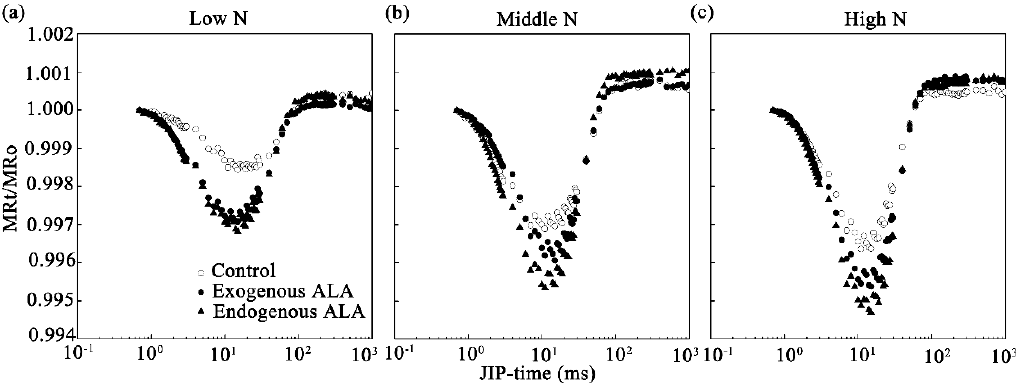
Figure 5. Changes in 820-nm modulated reflection (MR) curves, expressed as normalized MR (represented as MR t /MRo), in exogenously-treated or endogenous ALA-overproducing canola leaves grown under ( a ) low-, ( b ) middle-, and ( c ) high-N conditions.